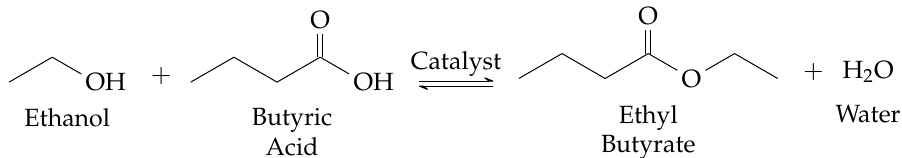
Figure 1. The chemical equation for the dehydration reaction of ethanol and butyric acid to form ethyl butyrate and